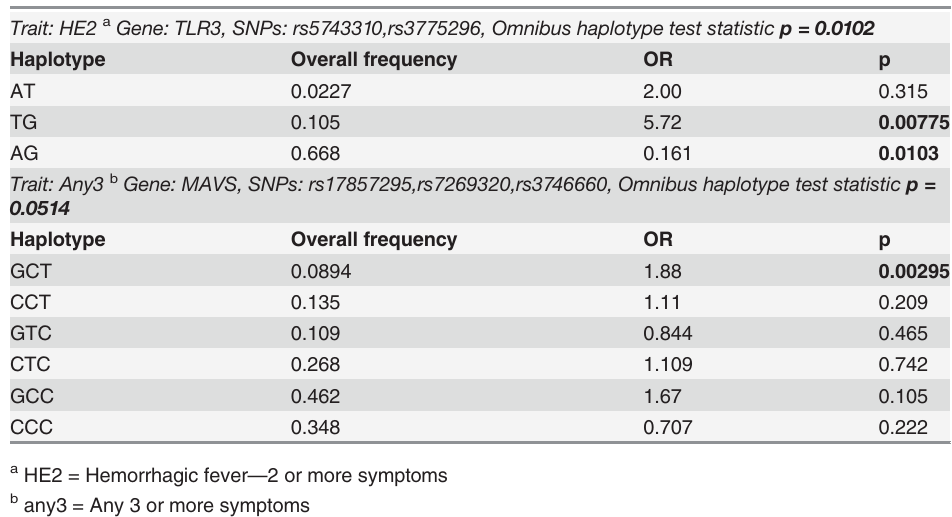
Table 6. Haplotype association